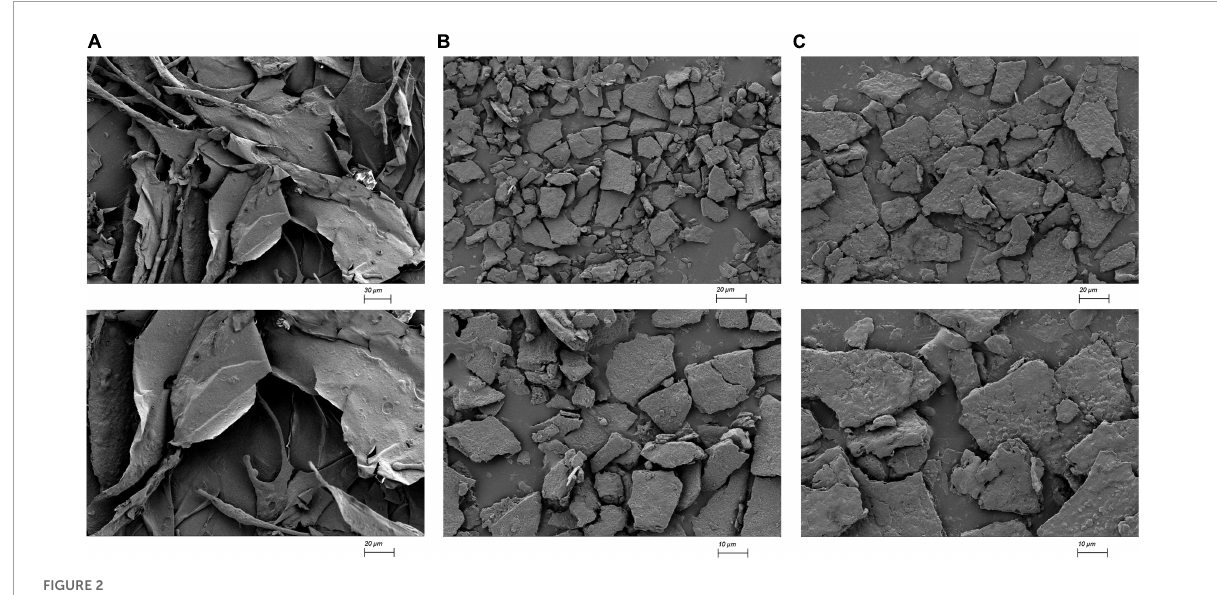
FIGURE2 SEM imaging of HWp (A) , HAp (B) , and HALp (C)